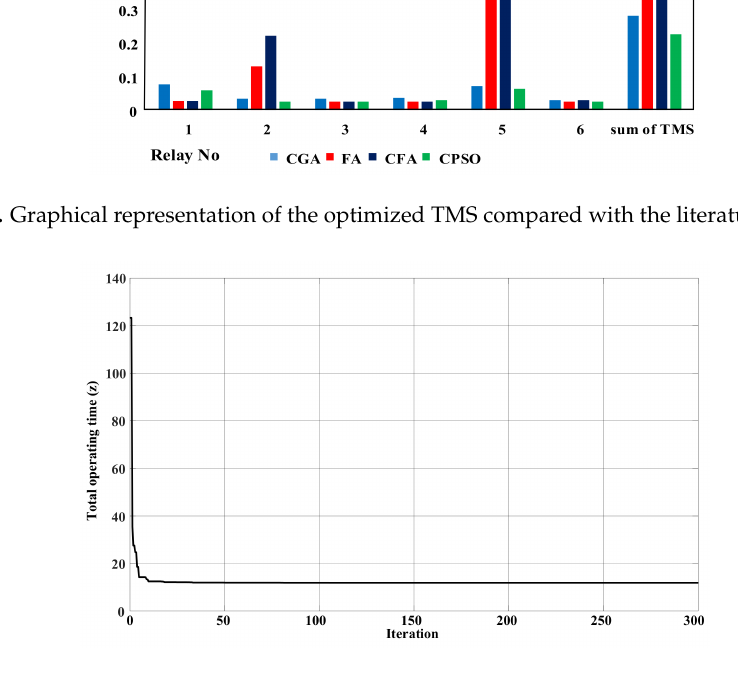
Figure 15. Convergence characteristic graph for Case IV. Table 19. Comparison of the total net gain in time achieved by the proposed algorithm compared with the literature for Case